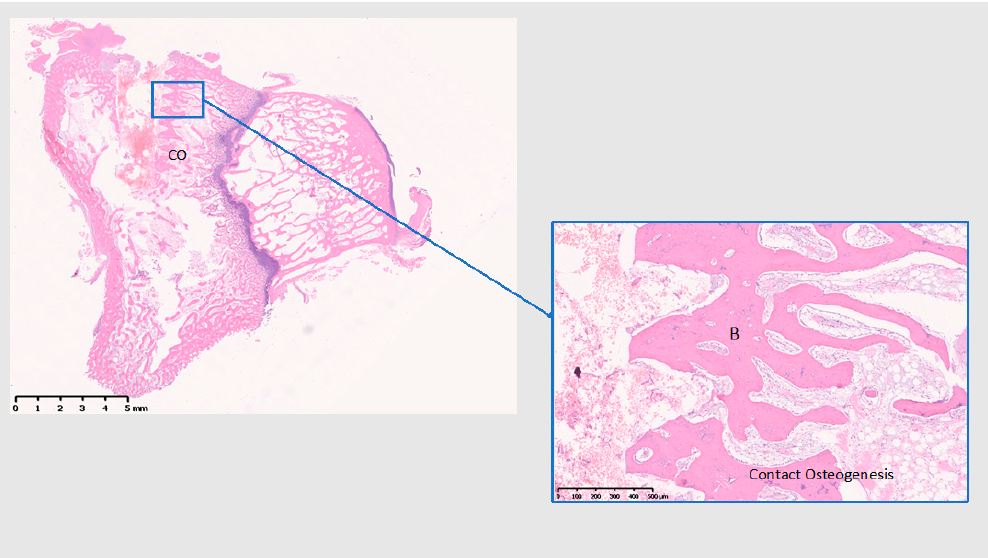
Figure 11. Histological analysis of Ti 28 (days). CO: contact osteogenesis. B: Bone. Formation of mature bone within the implant threads. Scale bars : 5 mm and 500 µm.